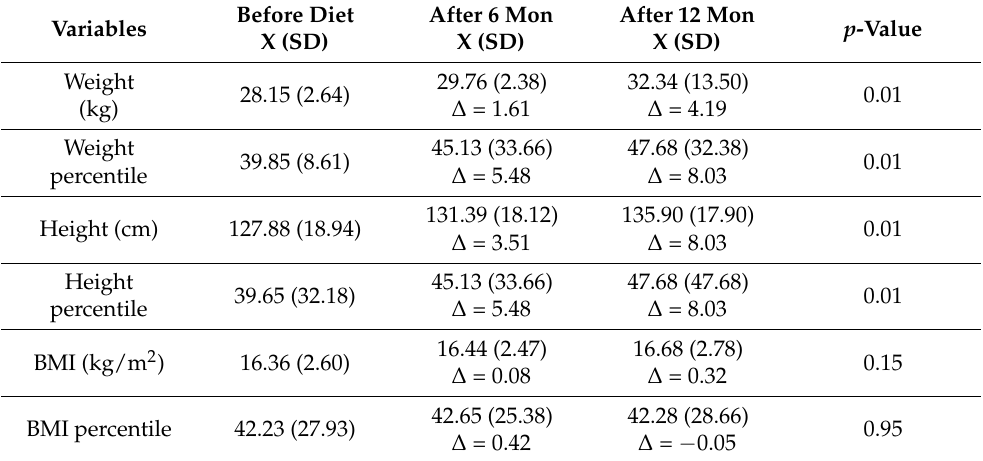
Table 1. Changes of anthropometric parameters in the studied